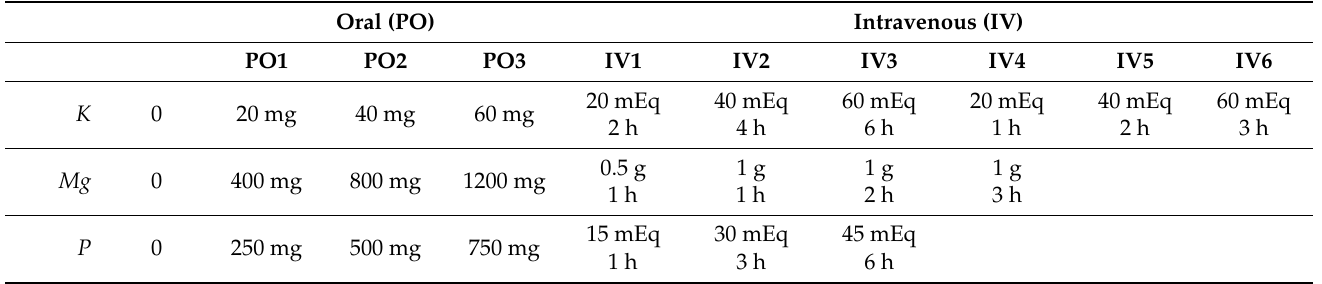
Table 2. Repletion of K, Mg, and P replacements in terms of dose and duration. Oral